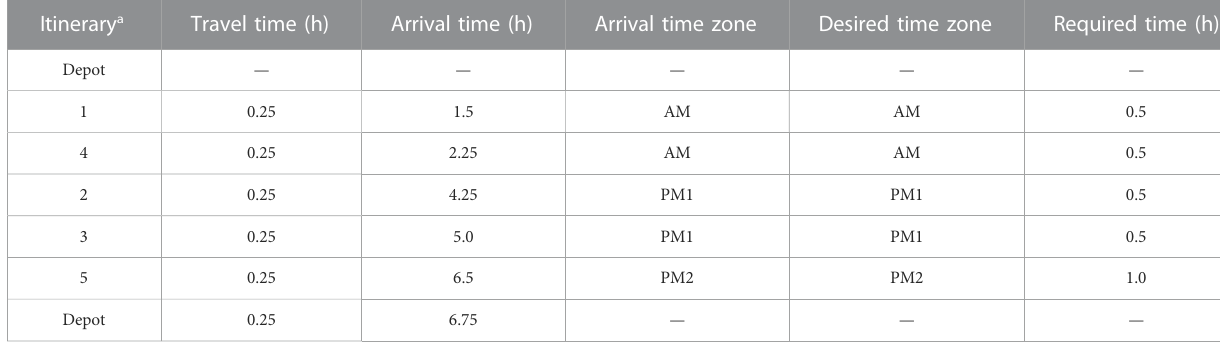
a The number (1, 2, 3, ... ) in the itinerary column is the ID of the building, not the order of the visits. The order of visits is from the top to the bottom of the column.